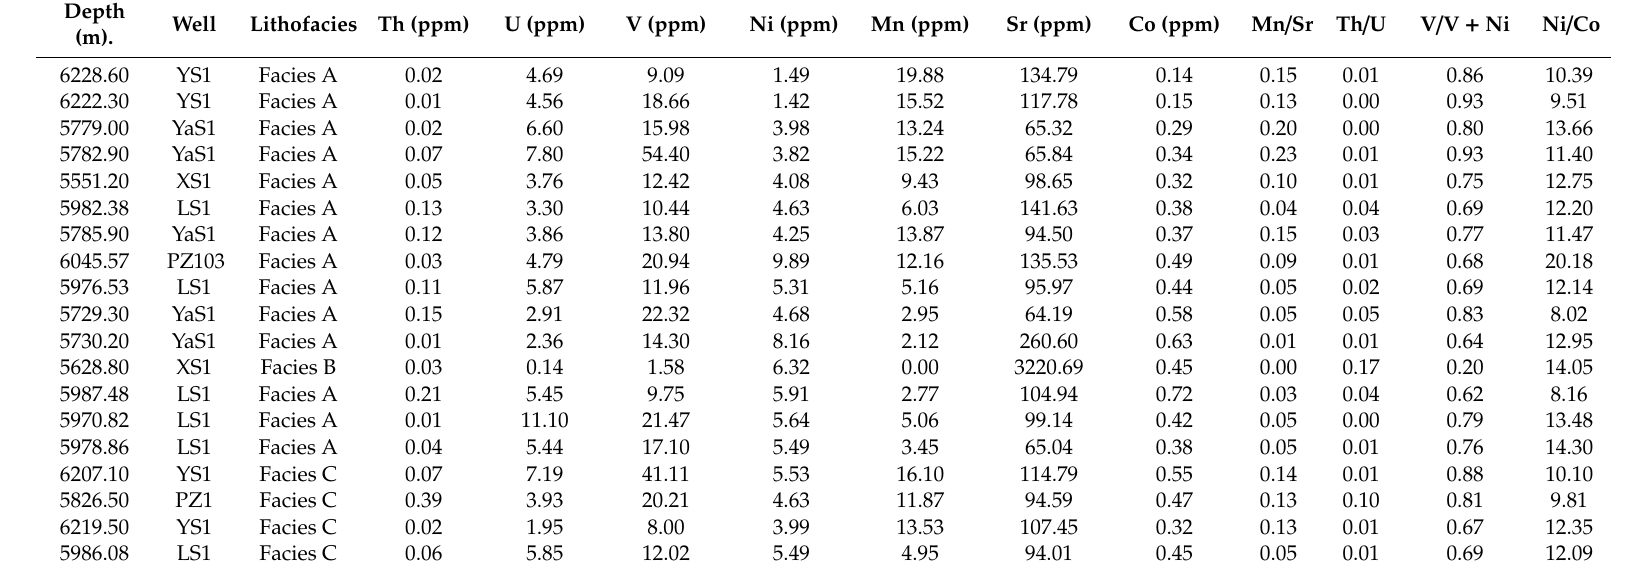
Table 3. Values of the redox-sensitive trace elements in the fourth member of the Leikoupo